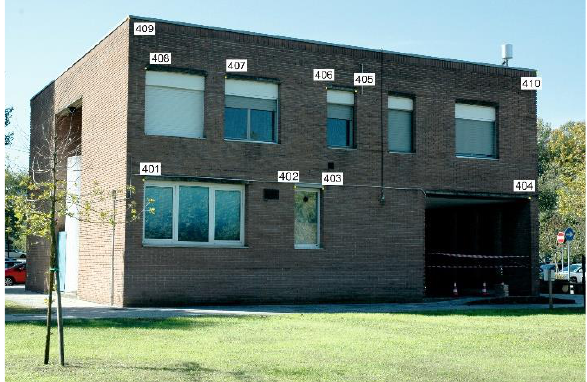
Figure 3 . The ten points belonging to building’s façade. Points on the facade were surveyed with a redundant topographic network; measurements were processed by least squares adjustment and so-estimated standard deviation values range between 5 and 7 mm.